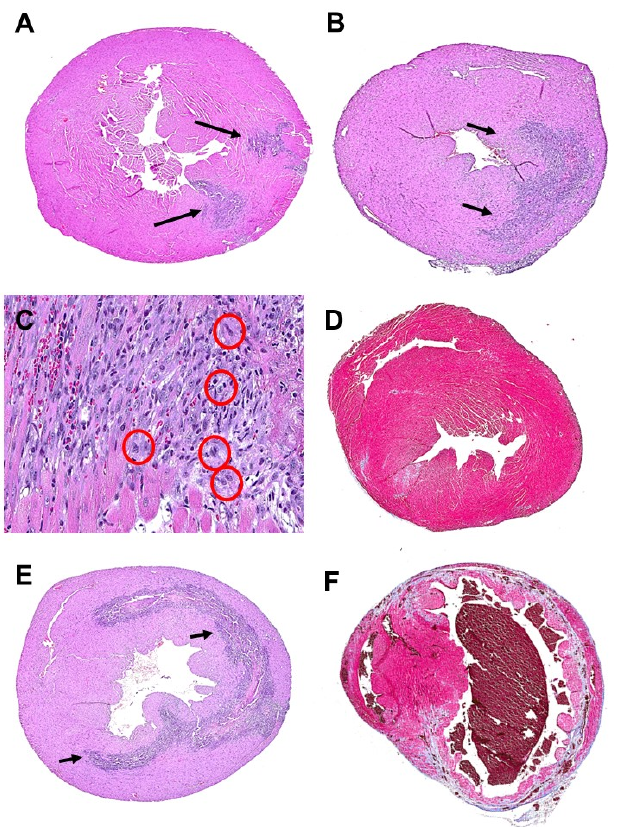
Figure 10. Regeneration ( A – D ) or fibrosis ( E , F ) of GT-KO mouse hearts undergoing MI by occlu- sion/reperfusion. ( A ) Heart treated with α -gal nanoparticles, 4 days post treatment. Arrows indicated macrophage infiltration in the two injection sites (H&E × 10). ( B ) Heart treated with α -gal nanoparticles, 7 days post treatment. Arrows indicated the peak infiltration of macrophages (H&E × 10). ( C ) Magnification of infiltration site in heart as in ( B ). Red circles mark mitotic figures at various stages of cell cycle (H&E × 200). ( D ) Near complete regeneration of a treated heart after 14 days (Masson trichrome × 10). ( E ) Saline treated heart after 4 days displays peak infiltration of macrophages, marked by arrows (H&E × 10). ( F ) Saline treated heart after 14 days displaying thinning of the anterior ventricular wall which also displays fibrosis, indicated by the blue-grey stained col- lagen (Masson trichrome × 10). Modified from ref. [19].